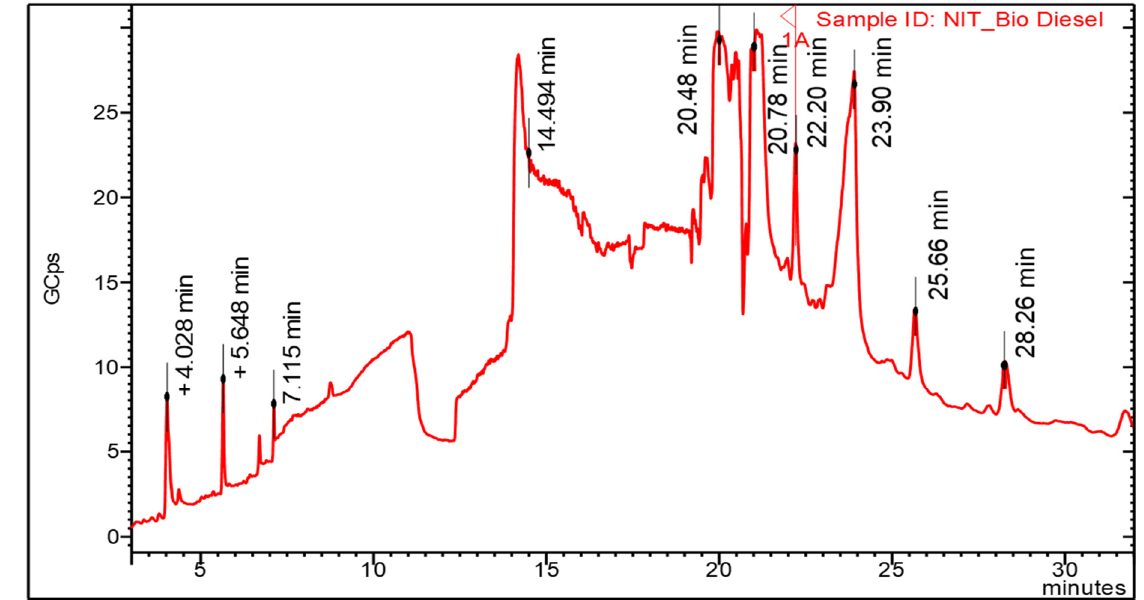
Figure 4. GC-MS Chromatogram of Kapok biodiesel. Table 3. Major fatty acids of Kapok oil-derived Biodiesel as per GC-MS analysis.